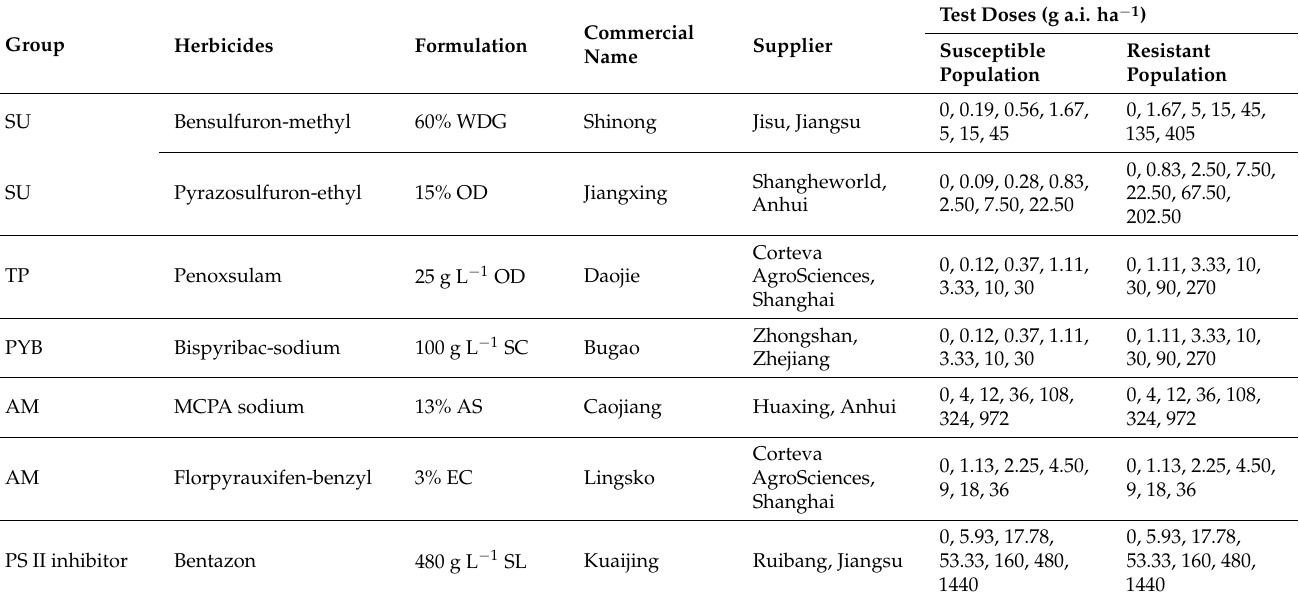
Table 1. Herbicides and rates used in whole-plant dose-response